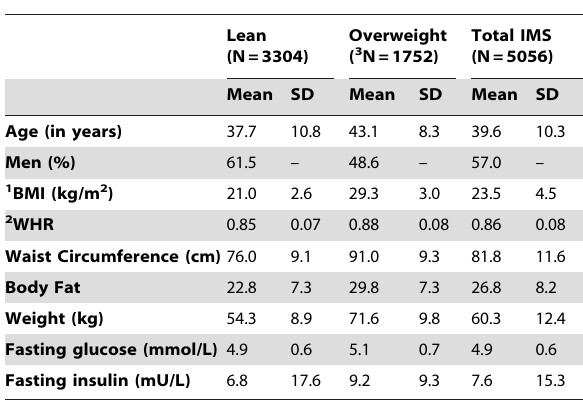
Table 1. Characteristics of Indian Migration Study